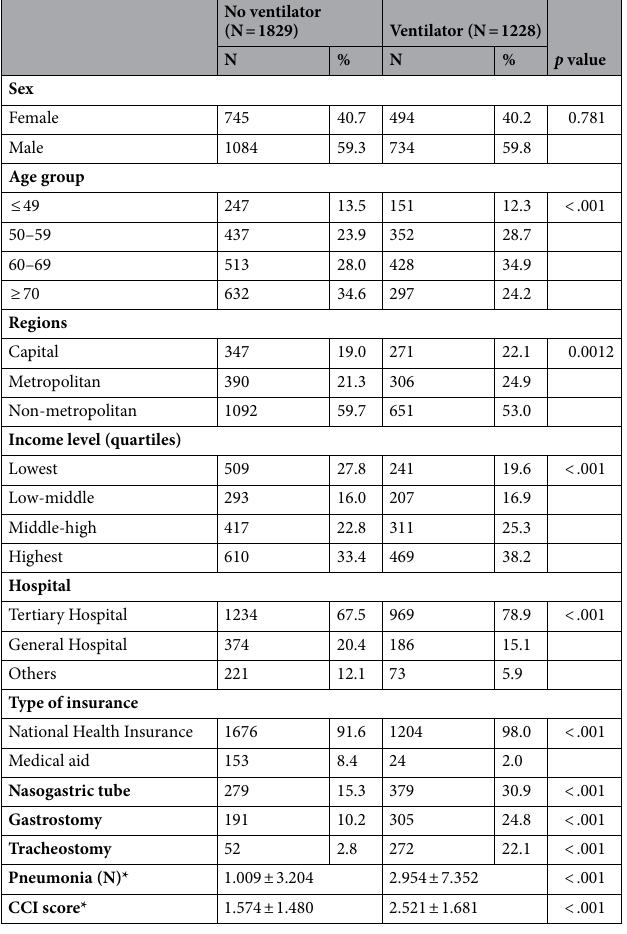
Table 1. Characteristics of the amyotrophic lateral sclerosis participants with ventilator (N = 1228) and without ventilator (N = 1829). *Mean ± standard